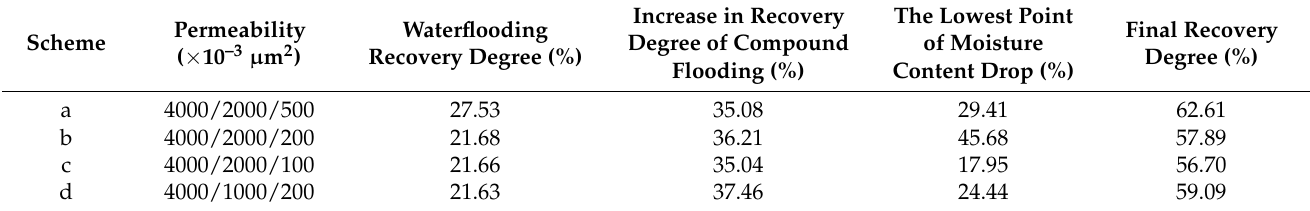
Table 6. The experimental results of the heterogeneous combination of different permeability in the layer.